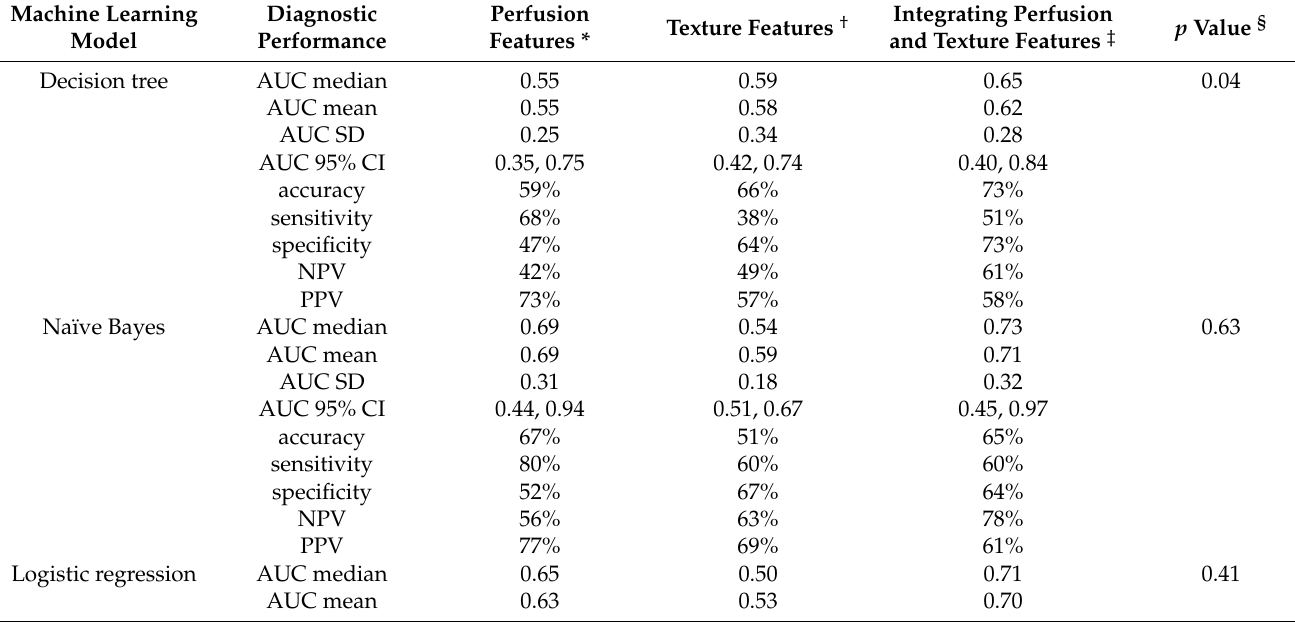
Table 4. Diagnostic performance of five machine learning models using perfusion and texture features to predict histological factors. Machine Learning Model Decision